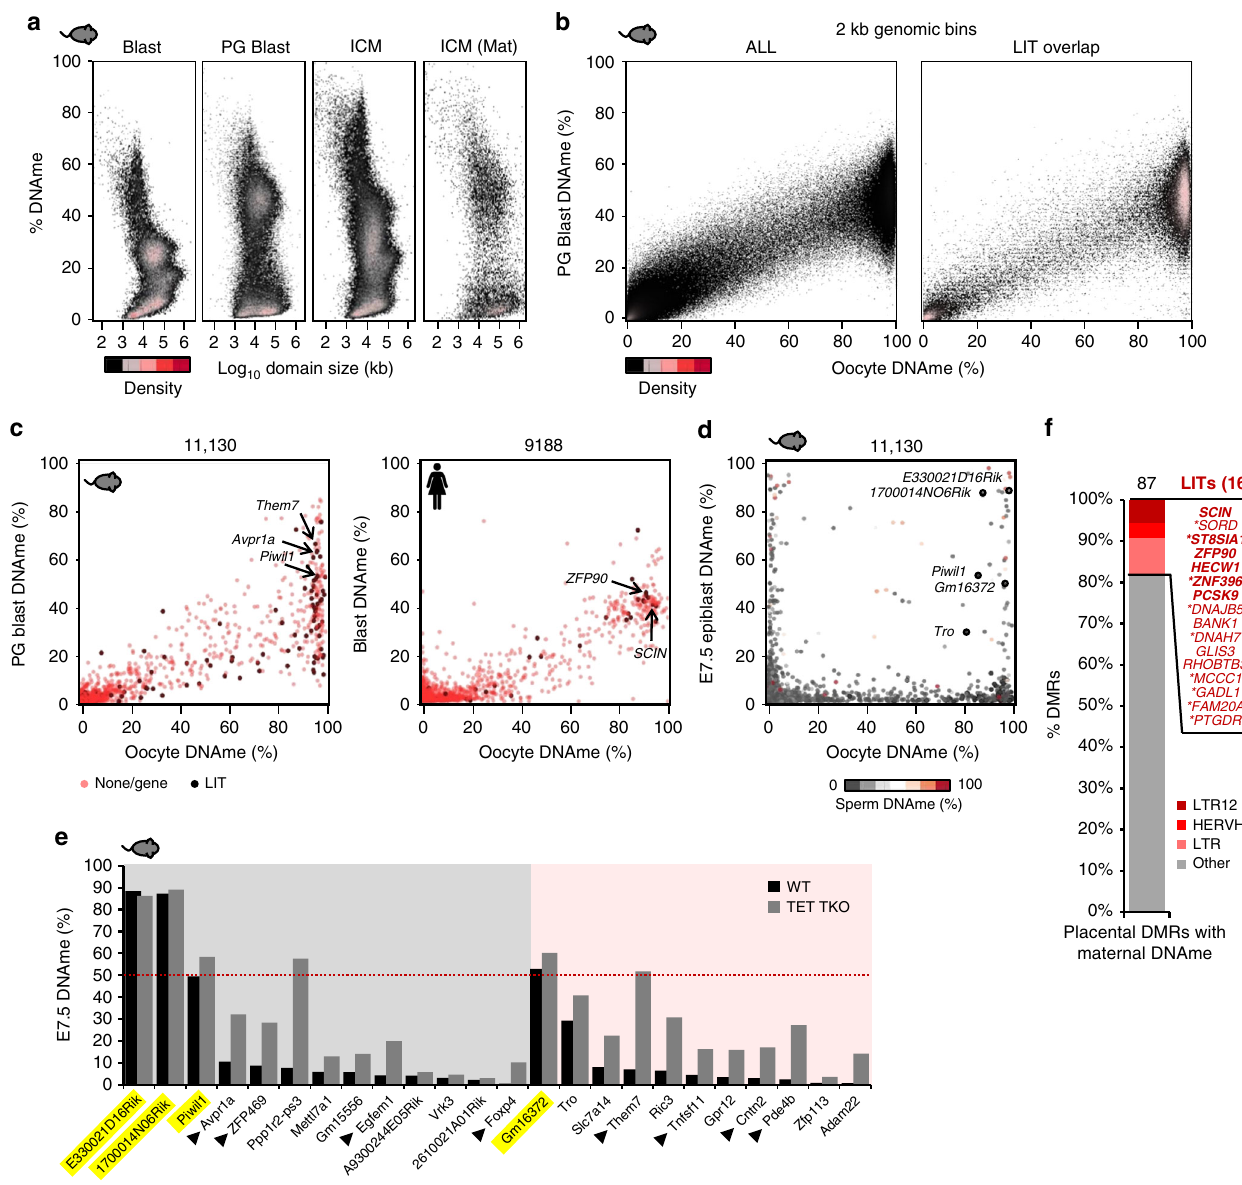
Fig. 5 Persistence of LIT-associated oocyte DNAme in mouse and human following fertilization. a Density plot depicting the distribution of DNAme in mouse blastocyst, PG blastocyst, ICM (C57BL/6×DBA F1 cross) and ICM (maternal allele). DNAme domains were identi fi ed using Changepoint analysis. b Density plots comparing oocyte DNAme to PG blastocysts over genome-wide 2 kb bins (left) or 2 kb bins overlapping an LIT (right). c . Scatter plots of oocyte vs PG blastocyst (mouse) or blastocyst (human) CGI promoter DNAme. Promoter CGIs overlapped by an LIT in oocytes are highlighted in black. d Scatter plots of oocyte vs E7.5 epiblast CGI promoter DNAme. Promoter CGIs overlapped by an LIT in oocytes are highlighted in black. Sperm DNAme is indicated as a color gradient. Note that the rat Piwil1 gene is oriented in the reverse direction. e DNAme in WT or Tet TKO E7.5 embryos over 24 promoter CGIs that gain DNAme as the result of LTR-initiated transcription in oocytes. Yellow highlight: genes showing apparent retention of maternal DNAme in E7.5 embryos. Black arrow: genes identi fi ed as TET targets in Dai et al. 28 ). Gray background: LITs present in C57BL/6 and Cast/Ei meCGIs; pink background: C57BL/6 private LITs. Note that the genes E330021D16Rik and 1700014NO6Rik also gain DNAme on the paternal genome in the peri- implantation stage (see d ). f Bar chart including 87 CGIs methylated on the maternal allele in human placenta 29 , categorized here via LIONS or manual inspection of de novo transcripts (*), as LIT or non-LIT (other) associated in oocytes. The 16 LIT-associated DMRs are further subcategorized based on annotated 5 ′ LTR. Bold: DMRs associated with paternal-speci fi c gene transcription in placenta (ref. 30 ). Mouse and human WGBS datasets analyzed from refs.